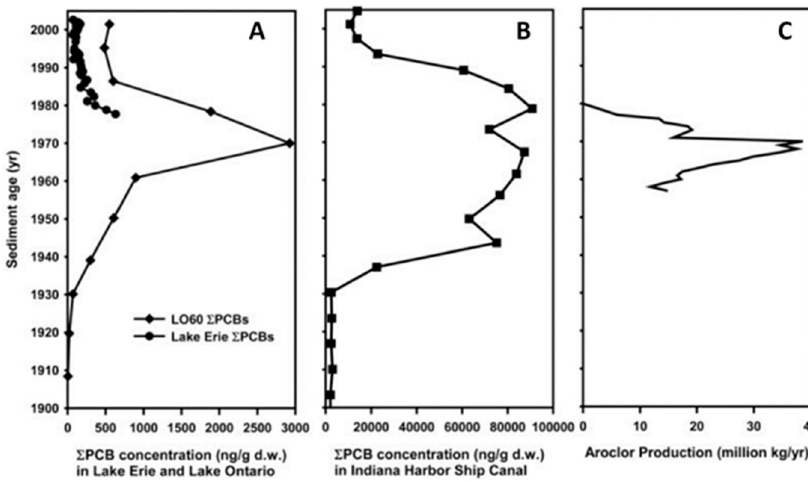
Figure 2. Σ PCB concentration trends in sediment from ( A ) Lake Erie and Lake Ontario, and ( B ) Indiana Harbor ship canal reflect production and use of commercial Aroclor mixtures in North America ( C ). Figure adopted from Hu and colleagues [21]. Copyright PMC 2011.